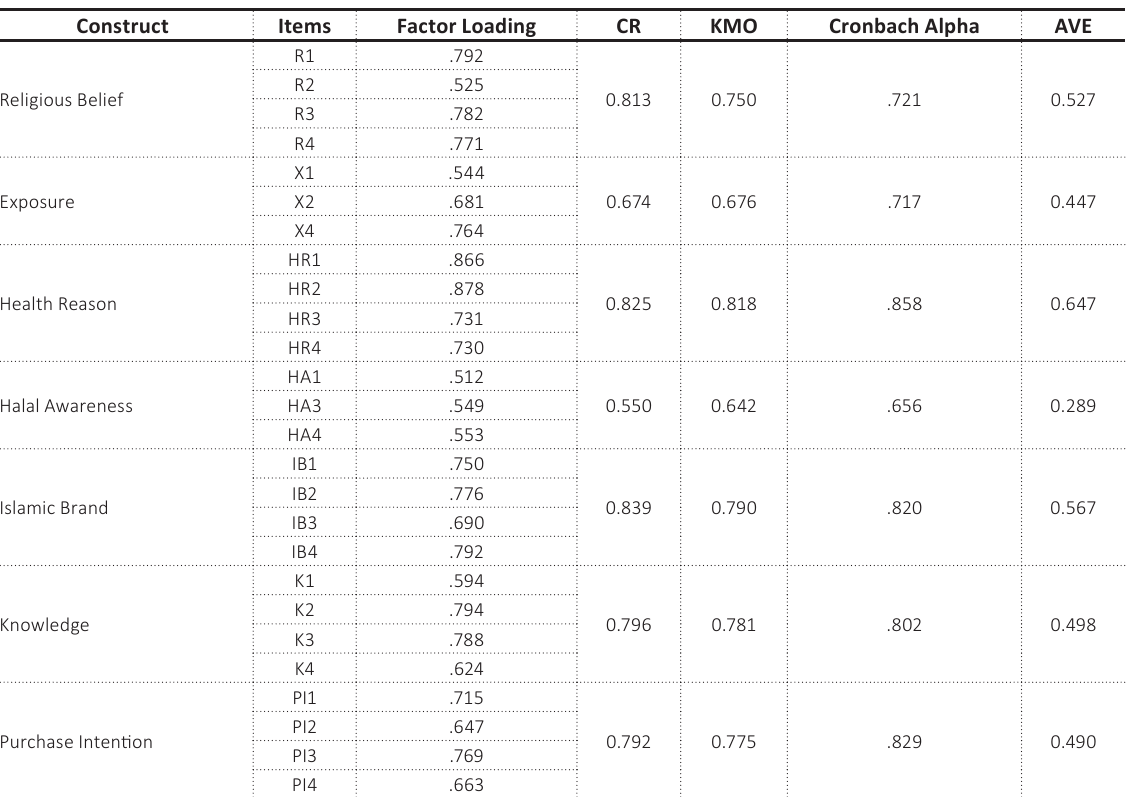
Table 2. Measurement